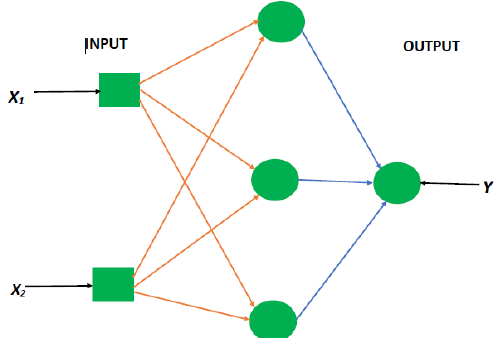
Figure 2. A graphical display of single layer feed-forward